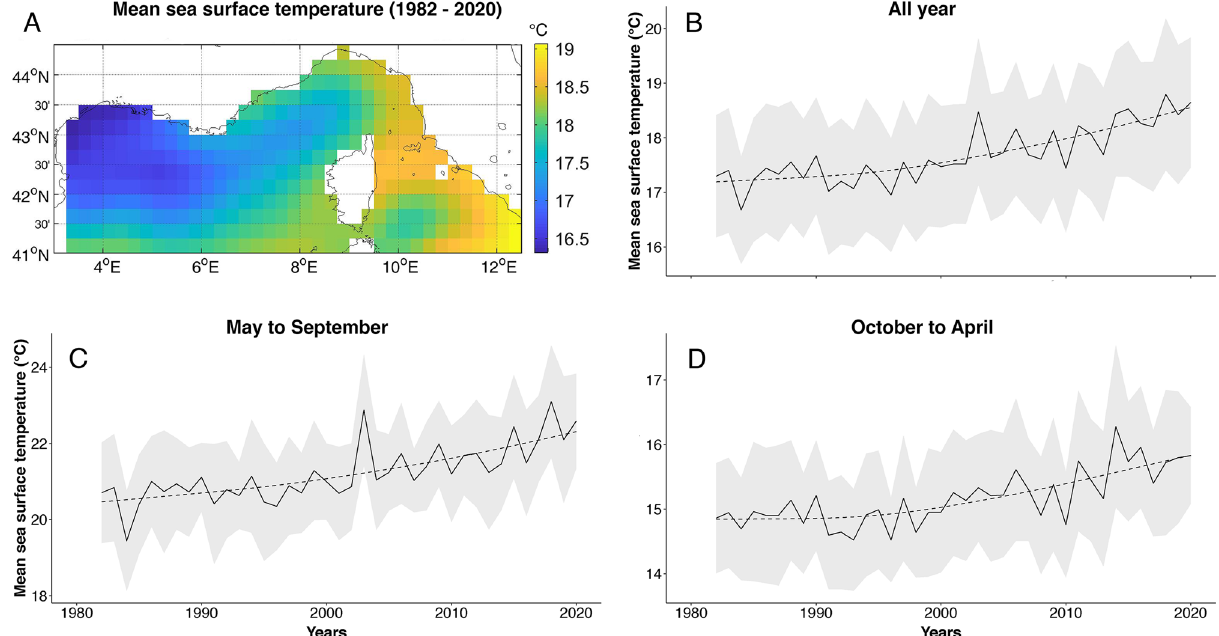
Figure 6. Evolution of sea surface temperature (SST) in the north-western Mediterranean between 1982 and 2020. ( A ) Mean SST calculated over the study area between 1982 and 2020. ( B ) Annual and ( C , D ) seasonal times series of mean SST. Shaded areas represent standard errors. Overall trends are indicated by dotted lines. SST data for this figure were extracted from the National Oceanic and Atmospheric Administration’s National Centers for Environmental Information website 56